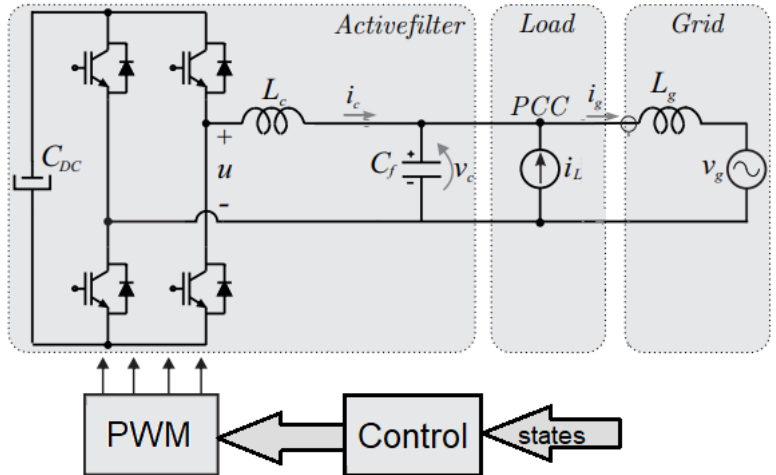
Figure 1. Nonlinear load and shunt APF connected to the grid at the PCC. Table 1. Parameters of the system under study.